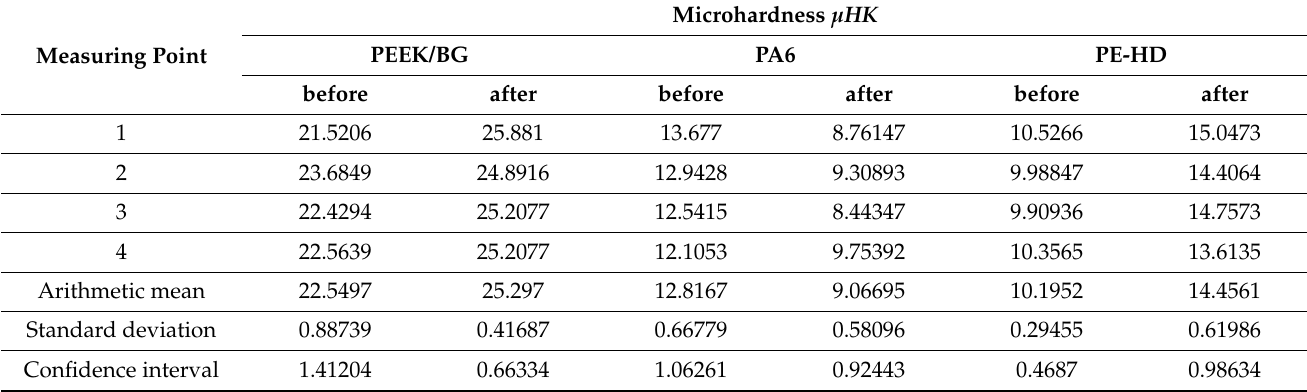
Table 6. Microhardness test results and their statistical interpretation.